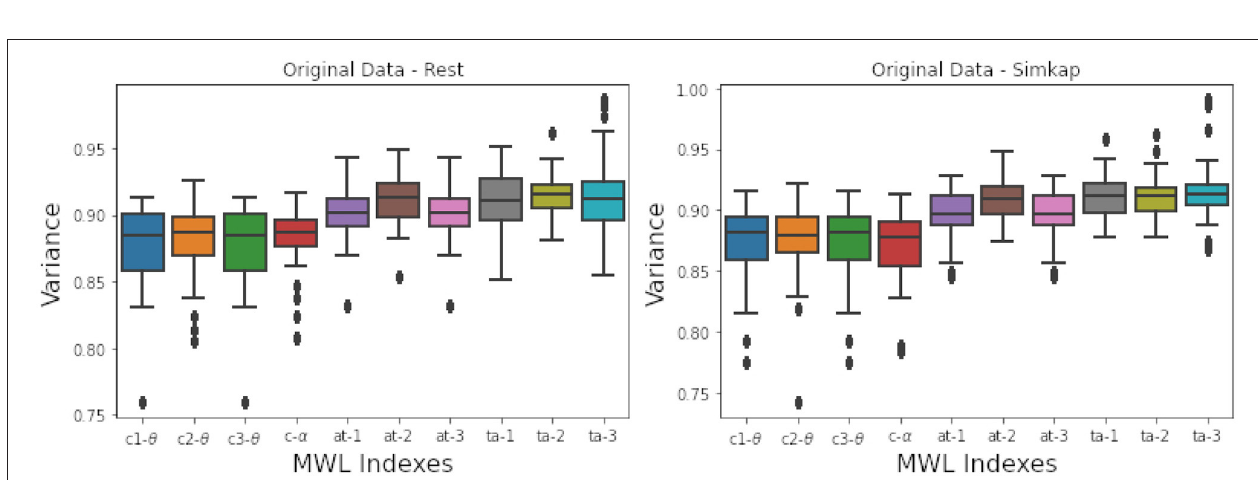
increases the bias influencing the model’s ability to